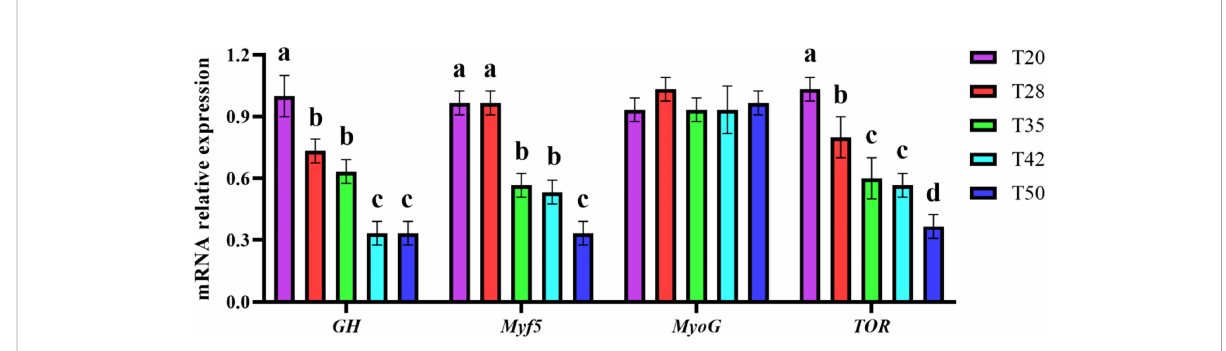
FIGURE 2 Muscle growth – related gene expression of L. vannamei fed with experimental diets. GH , growth hormone; Myf5 and MyoG , myogenic regulatory factors; TOR , target of rapamycin. Different letters above the bars denote signi fi cant differences among diets ( p < 0.05). T20 – T50, diets containing 20% – 50% of soybean